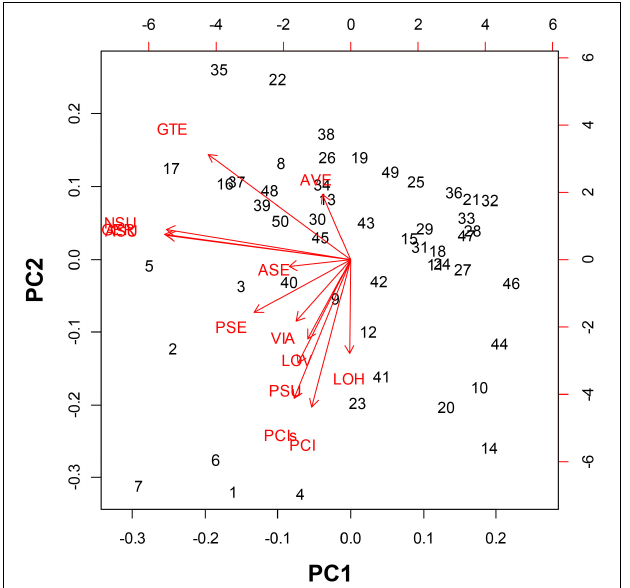
FIGURE 2 | Principal Component Analysis for seed morphology traits evaluated on 56 genotypes of purple passion fruit ( Passiflora edulis f. edulis Sims.), with numbers representing cultivars, landraces and accession, and based on the following characteristics: AVE = angle between seed vertices, GTE = seed coat/gross tegument width, NSU = number of seed pits per side, ASU = area of seed pits per side, GER = percentage (%) germination, PSE = perimeter of the seed, ASE = area of the seed, VIA = percentage (%) viability, LOV = length of the seed on vertical axis, LOH = length of the seed on the horizontal axis, PSU = perimeter of the seed pits, PCI = one hundred (100) fresh seed weight; and PCIs = one hundred (100) dried seed weight.